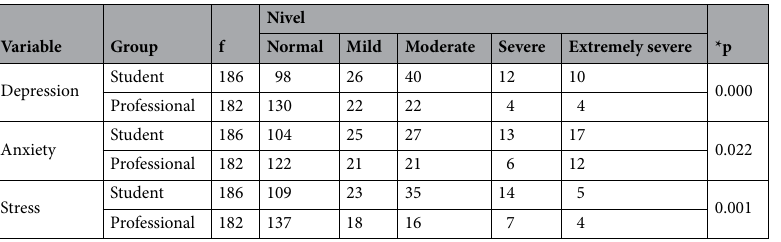
Table 2. Comparison of Depression, Anxiety and Stress levels among dental students and professionals in a Lima population during the second wave of COVID-19. f absolute frequency, Based on Whitney’s Mann’s U; p < 0.05 (significant differences).